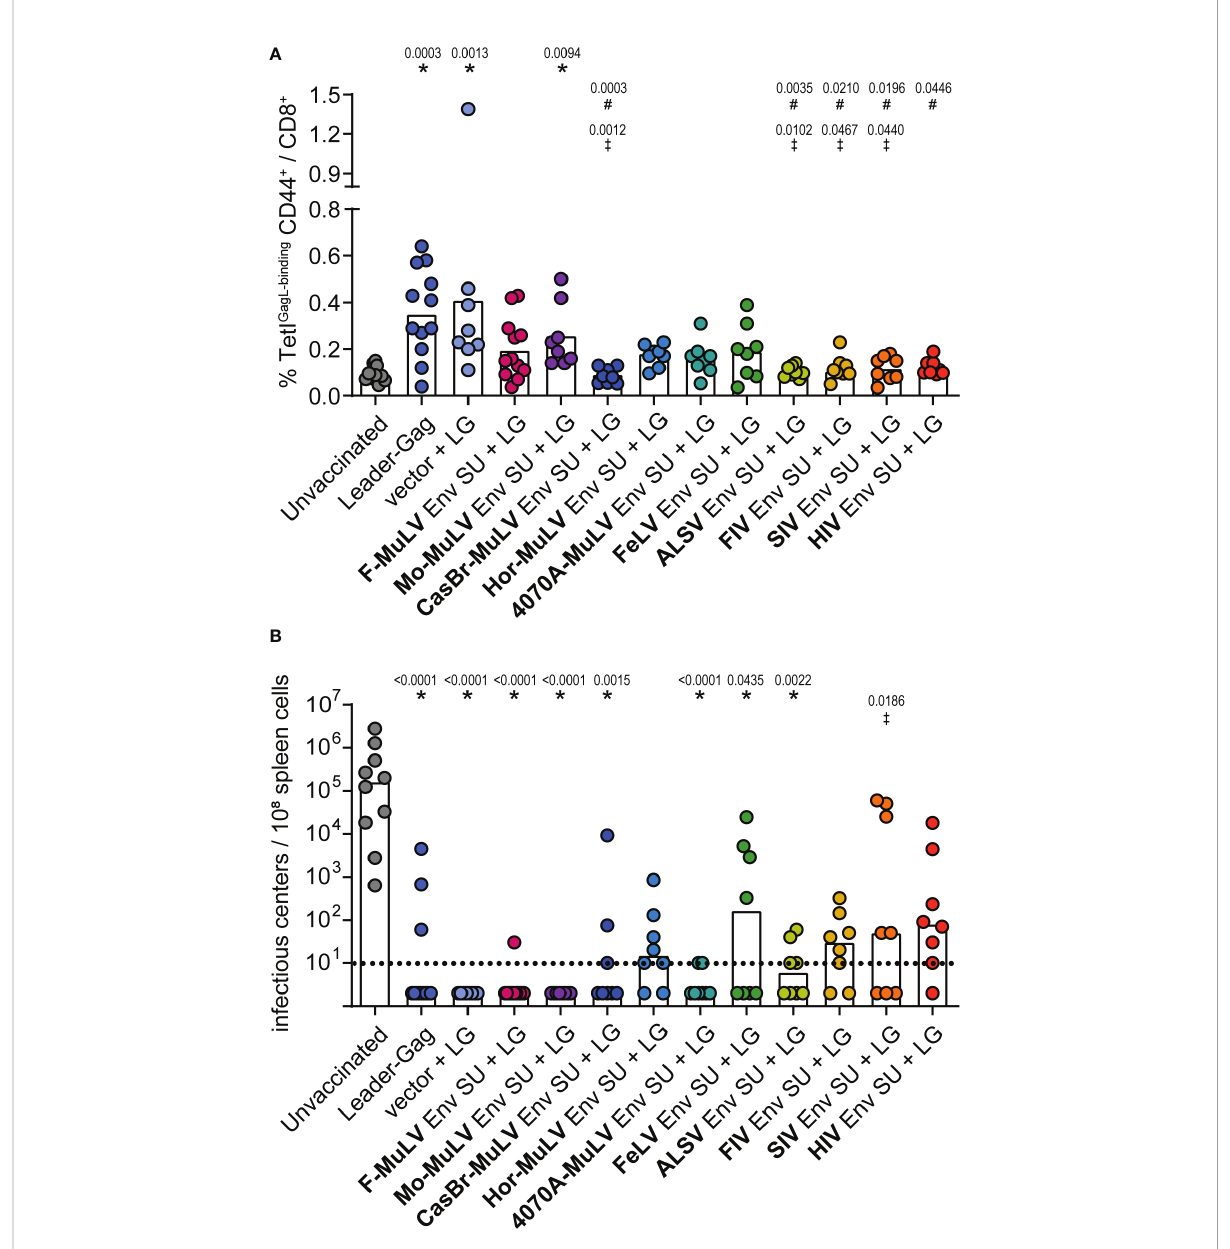
FIGURE 6 F-MuLV Leader-Gag-speci fi c CD8 + T-cell response after co-immunization with different Env SU-encoding plasmids. CB6F1 mice were immunized twice in a 3-week interval with 25 µg of pCG.Leader-Gag with or without co-immunization with 25 µg of a plasmid encoding SU Env of F-MuLV, Mo-MuLV, CasBr-MuLV, Hor-MuLV, 4070A-MuLV, FeLV, ALSV, FIV, SIV, or HIV or a control plasmid by intramuscular injection followed by in-vivo electroporation. Two weeks after the boost immunization, the frequency of GagL 85-93 -speci fi c CD8 + T cells was analyzed in peripheral blood (A) . Three weeks after booster vaccination, the mice were infected with 5,000 SFFU FV by intravenous injection. Three weeks after the FV challenge, mice were sacri fi ced and the viral loads in the spleens were determined (B) . Data from 8 to 12 mice per group were acquired in two to three independent experiments. Each dot indicates an individual mouse, and bars indicate mean (A) or median values (B) . Statistically signi fi cant differences compared with the unvaccinated group are indicated by *, differences compared with the Leader-Gag group are indicated by # and differences compared with the vector + LG group are indicated by ‡ ( p < 0.05, Kruskal – Wallis one-way ANOVA on ranks, Dunn ’ s